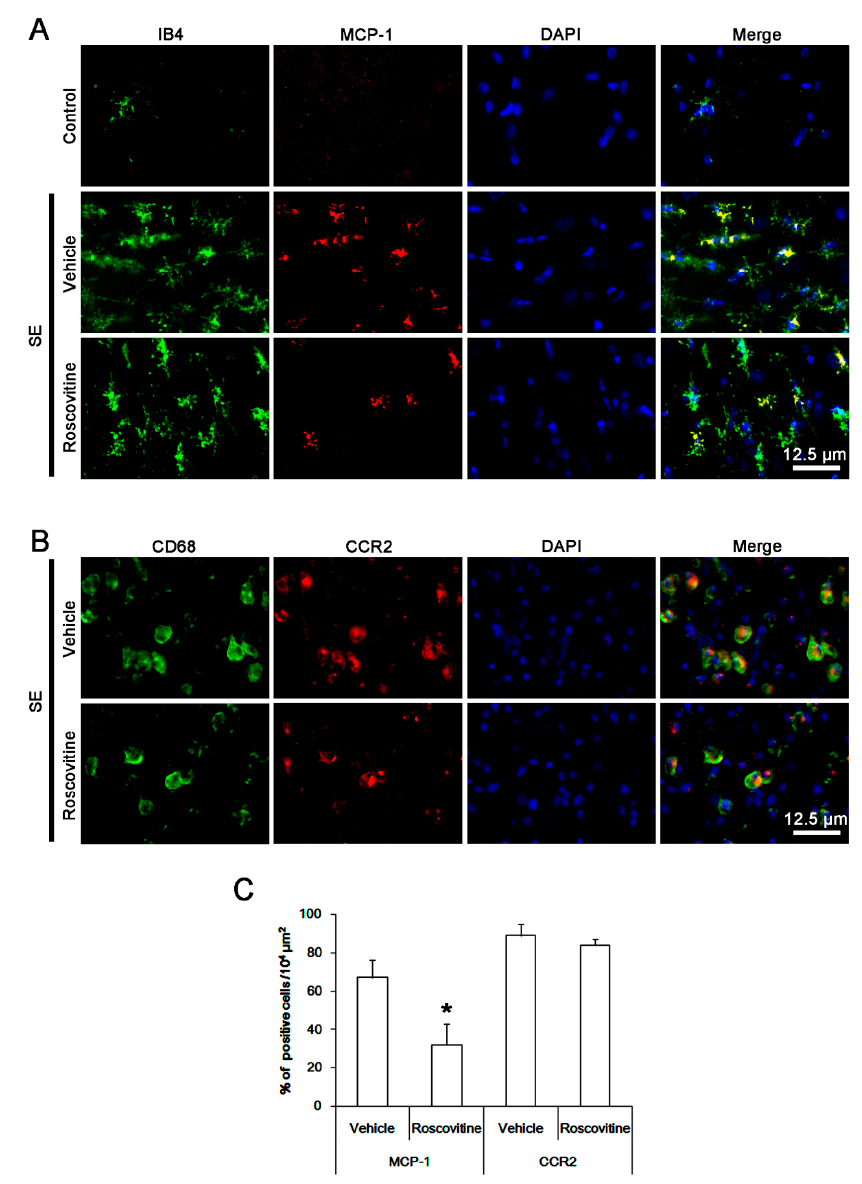
Figure 2. The effect of roscovitine on MCP-1 induction after SE. Three days after SE, MCP-1 expression is increased in resident IB4 microglia in vehicle-treated animals, while it is rarely detected under physiological condition. CD68 cells show CCR2 (receptor for MCP-1) expression. Following SE, roscovitine diminishes MCP-1 expression in IB4 microglia. However, CCR2 expression in CD68 cells is unaffected by roscovitine. ( A , B ) Representative images for MCP-1 and CCR2 expression in IB4 microglia and CD68 cells, respectively. ( C ) Quantification of the effect of roscovitine on MCP-1 and CCR2 expression in IB4 microglia and CD68 cells following SE. Error bars indicate SEM ( *p < 0.05 vs. vehicle-treated animals; n = 7, respectively).